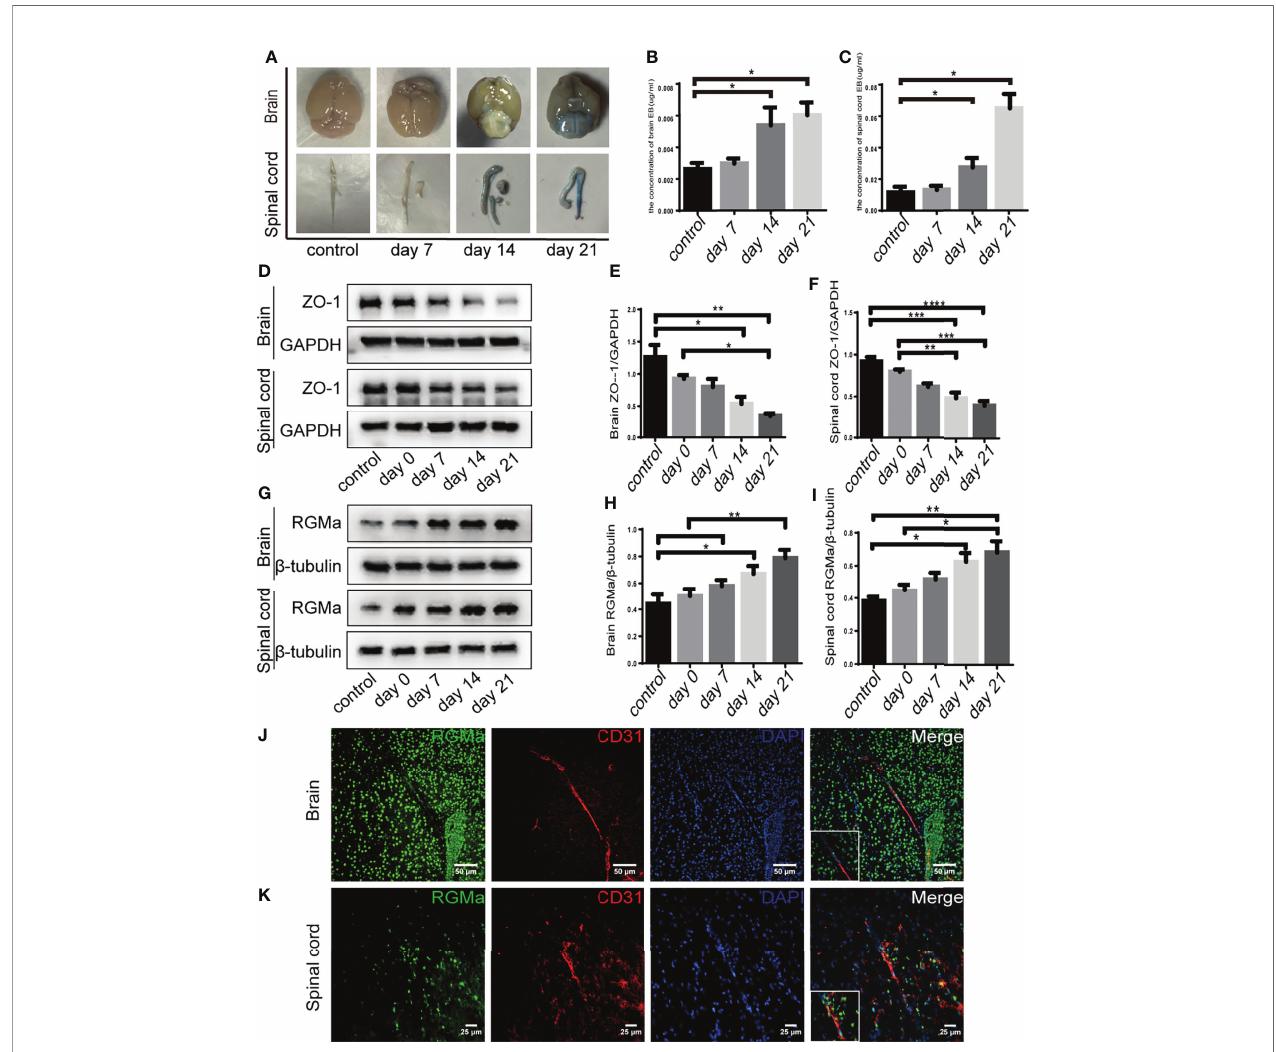
FIGURE 1 | RGMa is associated with blood – brain barrier disruption in EAE mice. (A – C) Quantitative analysis of Evans Blue Dye staining showed BBB disruption was signi fi cantly higher in both the 14-day group and the 21-day group compared with the control group (control vs. 14 days: brain, * p < 0.05; spinal cord, **** p < 0.0005; control vs. day 21: brain, * p < 0.05; spinal cord, * p < 0.05). (D – F) In both the brain and spinal cord, ZO-1 expression levels were decreased at both 14 and 21 days compared with the control group or 0-day group. (G – I) RGMa expression was signi fi cantly increased in the brain and spinal cord at 14 and 21 days compared with the control or 0-day groups, and signi fi cantly increased at the 21-day group compared with 7-day group ( n = 4, error bar: SEM; * p < 0.05, ** p < 0.01, *** p < 0.001, **** p < 0.0001, one-way ANOVA with Bonferroni). (J – K) RGMa and CD31 + endothelial cells were found colocalized in the brain cortex and spinal cord white matter. Scale bar: 50 µm (brain), 25 µm (spinal